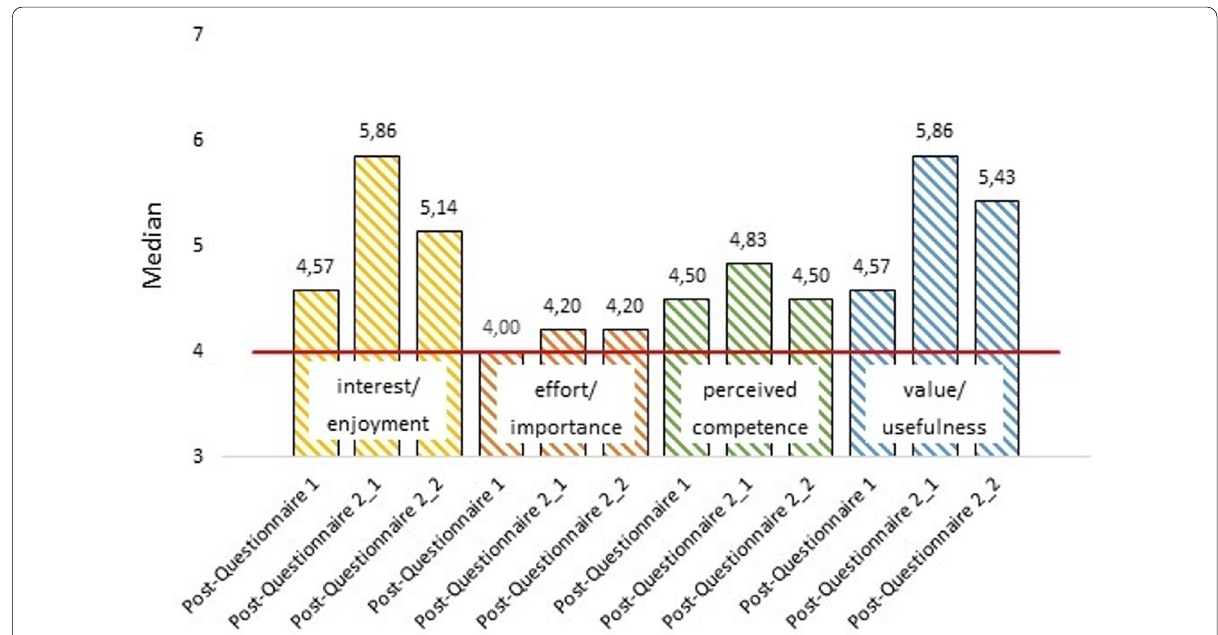
Fig. 3 The bar chart illustrates the medians of the components of intrinsic motivation after the control lesson, after the first experimental lesson and after the last experimental lesson (seven-item Likert’s scale)